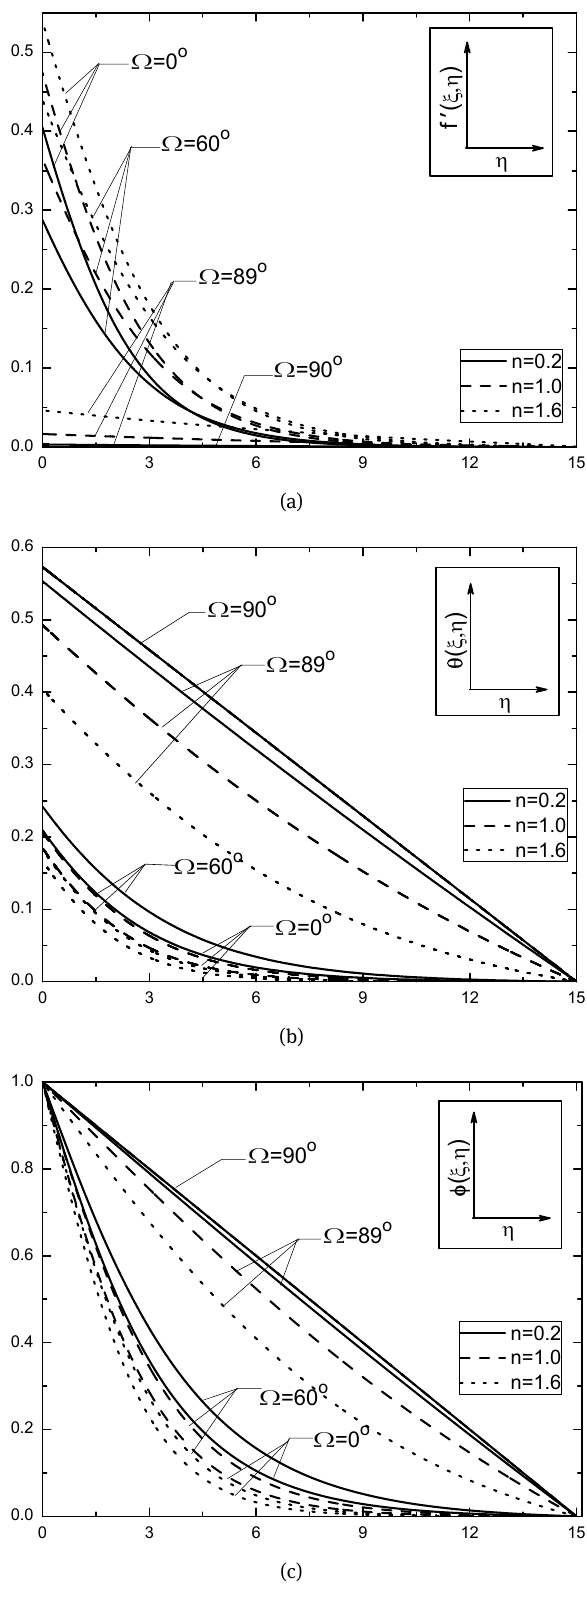
Fig. 6: Effect of Ω for different values of n on the (a) velocity, (b) temperature, and (c) concentration with the fixed values of α 1 = 1 , α 2 = 1 , Bi = 0.1 , ξ = 0.5